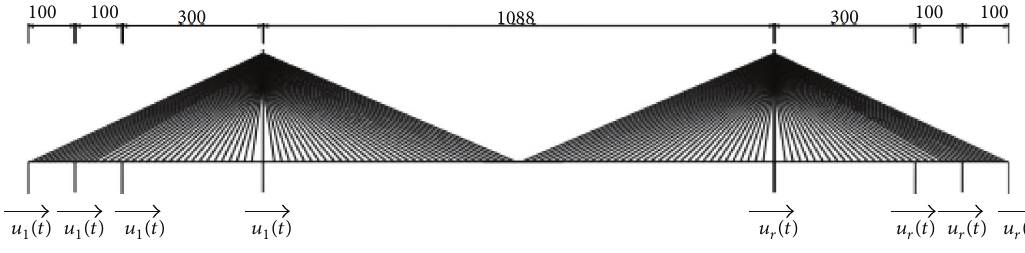
Figure 16: Grouping uniform excitation